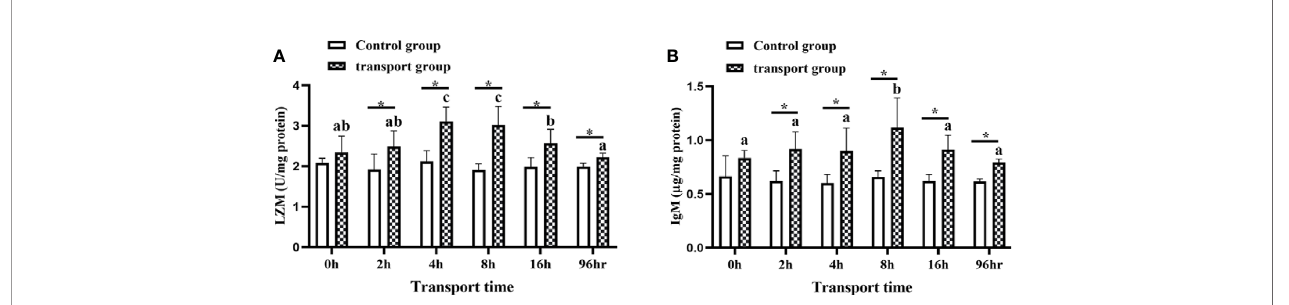
FIGURE 3 | Lysozyme (LZM) activity (A) and immunoglobulin M (IgM) levels (B) in skin mucus of transported and recovery groups. Values are mean ± SD ( n =12). Asterisk (*) indicates signi fi cant differences ( P < 0.05) between control group and transport group. Different small letters indicate signi fi cant differences ( P < 0.05) among time points within the